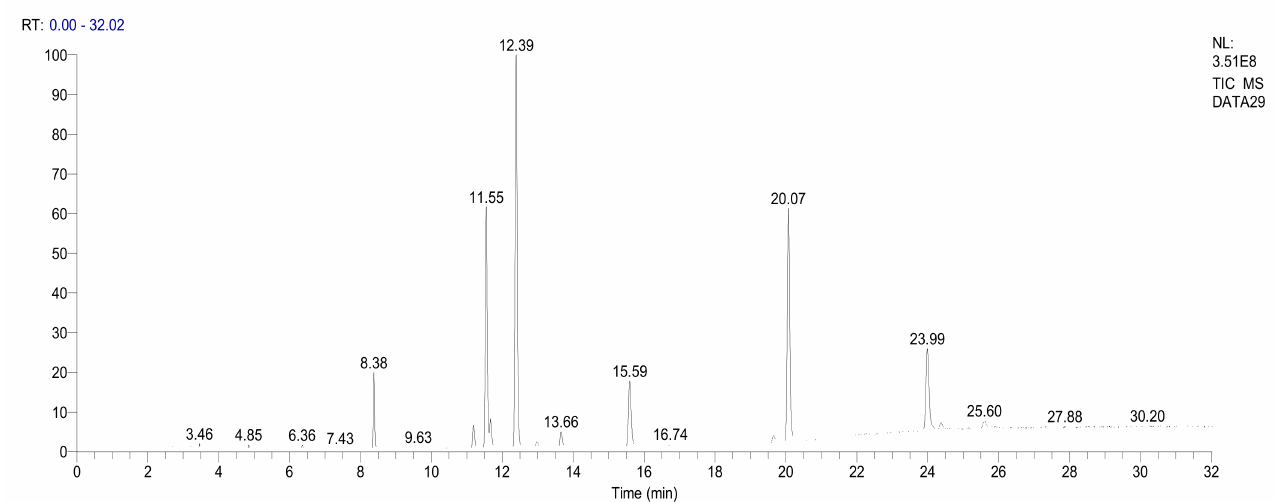
Figure 1. The total ion chromatograms of fatty acid methyl ester (CF-2) of A. truncatum seed oil. Note: